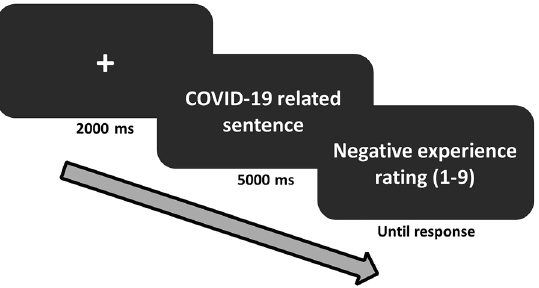
Figure 1. Negative experience rating task. Illustration of a trial structure in Study